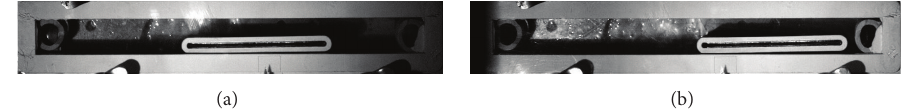
Figure 8: The body in the vibrating container in the extreme positions of the last, 𝑏 = 32.6 mm, 𝑓 = 10.5 Hz, ] = 1.04 St.